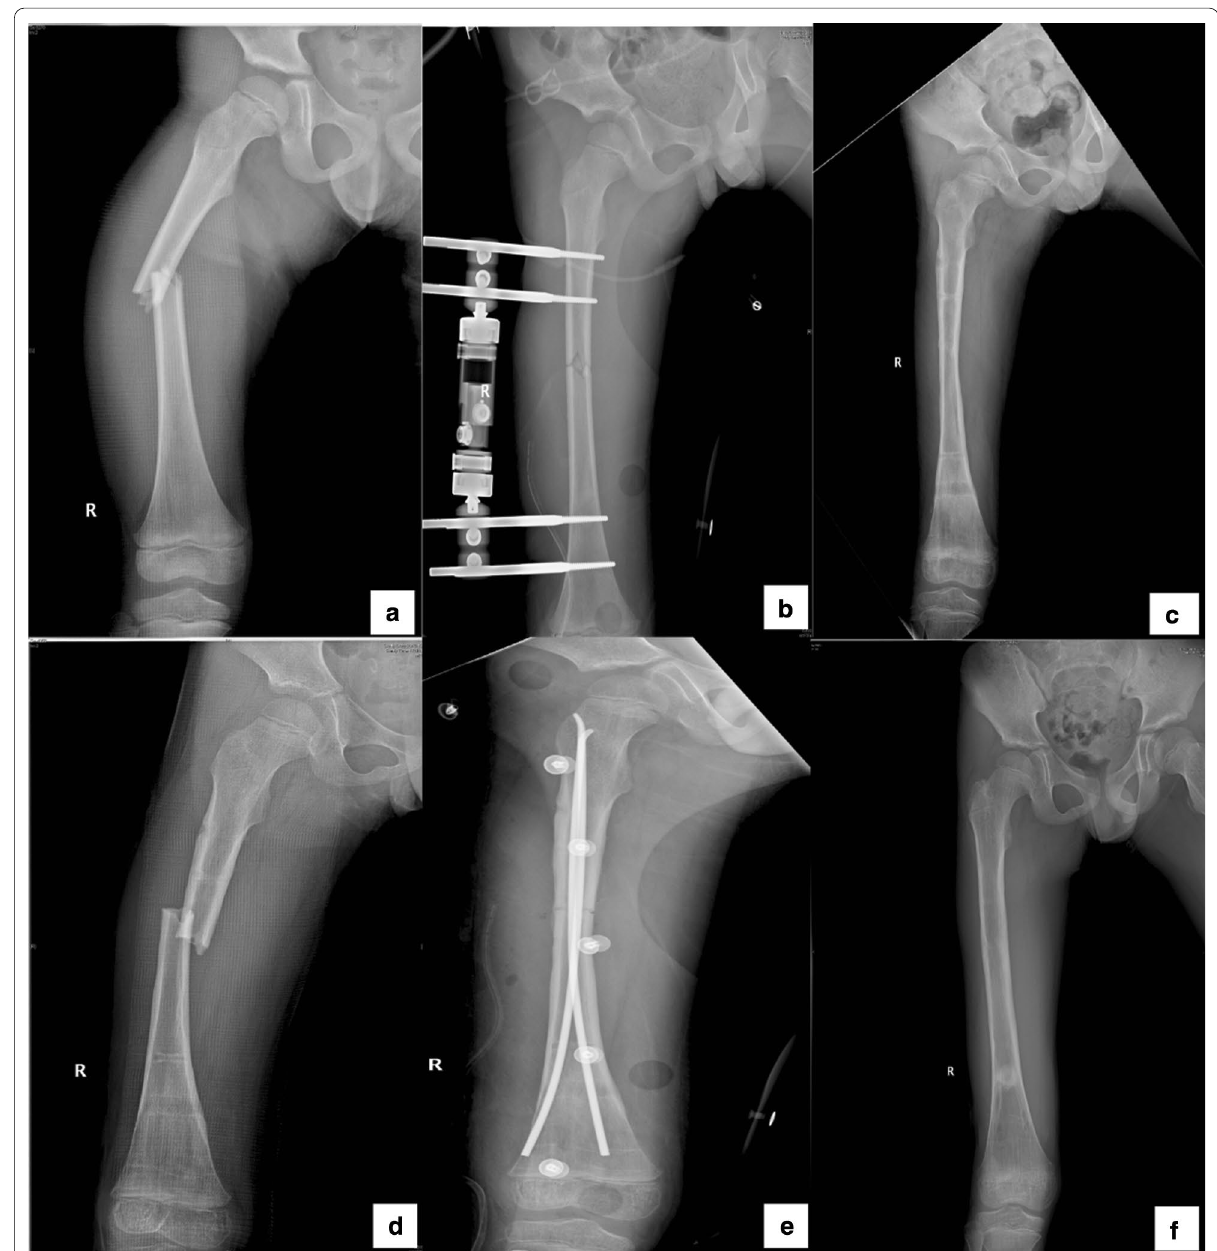
Fig. 2 Radiograph showing the right femoral shaft fracture in a 6-year-old male patient. a Initial fracture; b Fracture treated with external fixation (EF); c Removal of EF after 8 months; d At the fourth week after the fixation removal, refracture, unfortunately, happened due to a fall; e Refracture treated with an elastic intramedullary nail; f Removal of the fixator after 11 months. No refracture occurred within 1